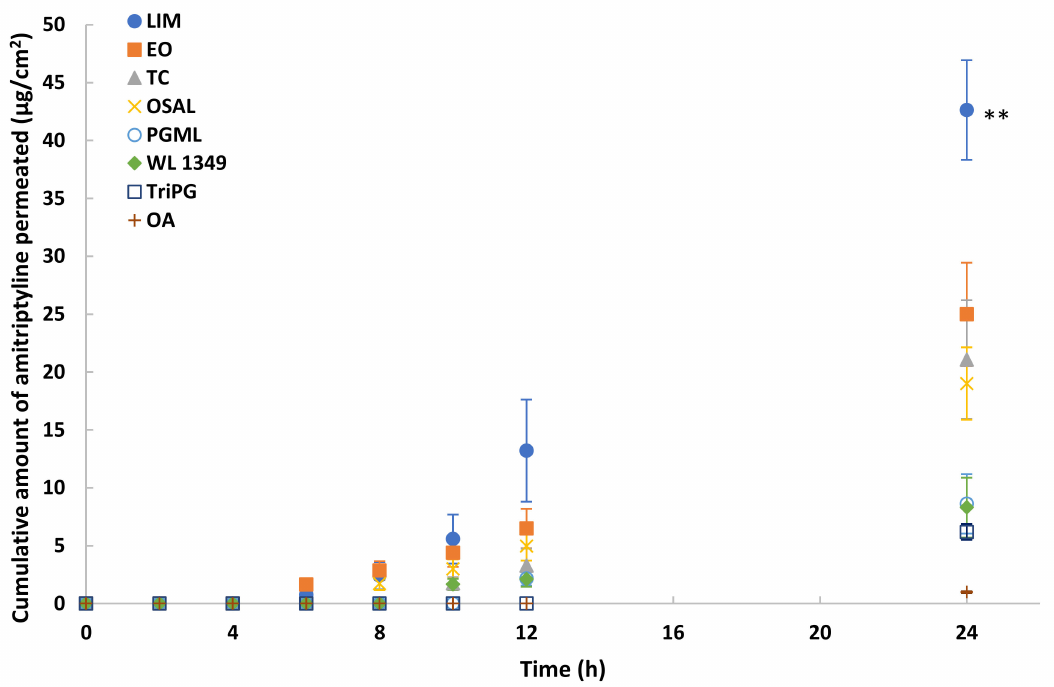
Figure 5. Cumulative permeation profiles of methadone in porcine skin after application of 5% ( w / v ) methadone free base in LIM ( (cid:8) ), EO ( (cid:4) ), TC ( (cid:78) ), OSAL ( × ), PGML ( ( + ) for finite dose (5 µ L / cm 2 ) at 32 ± 1 ◦ C. Each data point represents the mean ± SD (mean ± SD; 4 ≤ n ≤ 5). ** p <